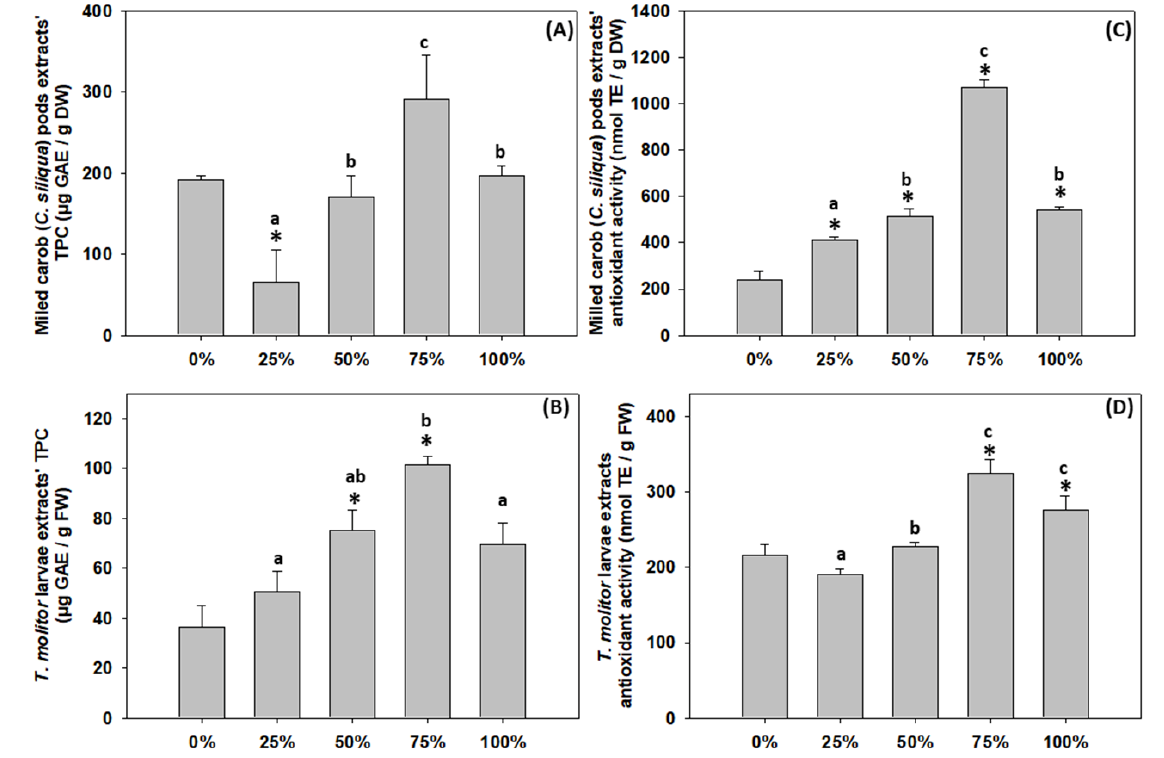
Figure 4. Total phenolic contents ( A , B ) and antioxidant activities ( C , D ) of carob pods used as feeding substrate at different content levels (0, 25, 50, 75, 100%) and Tenebrio molitor larvae, respectively. Values represent means ± SD. Asterisk (*) indicates p < 0.05 compared to 0%, while lower case letters indicate p < 0.05 compared to different carob contents (%).